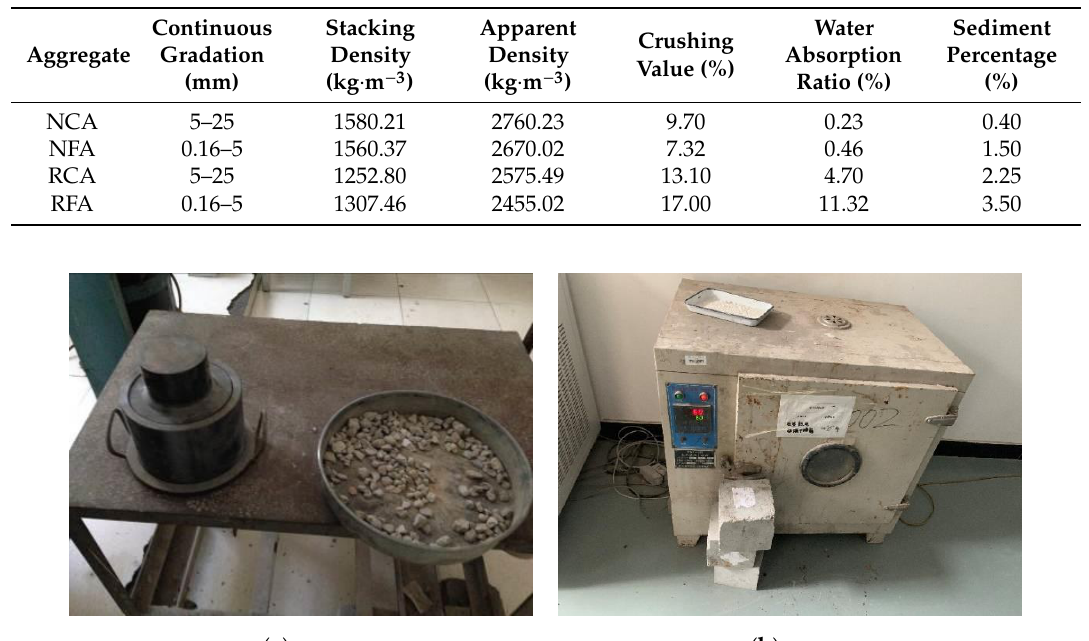
Figure 4. Instruments used for measuring the basic properties of the aggregates . ( a ) Crushing index; ( b ) Water absorption.